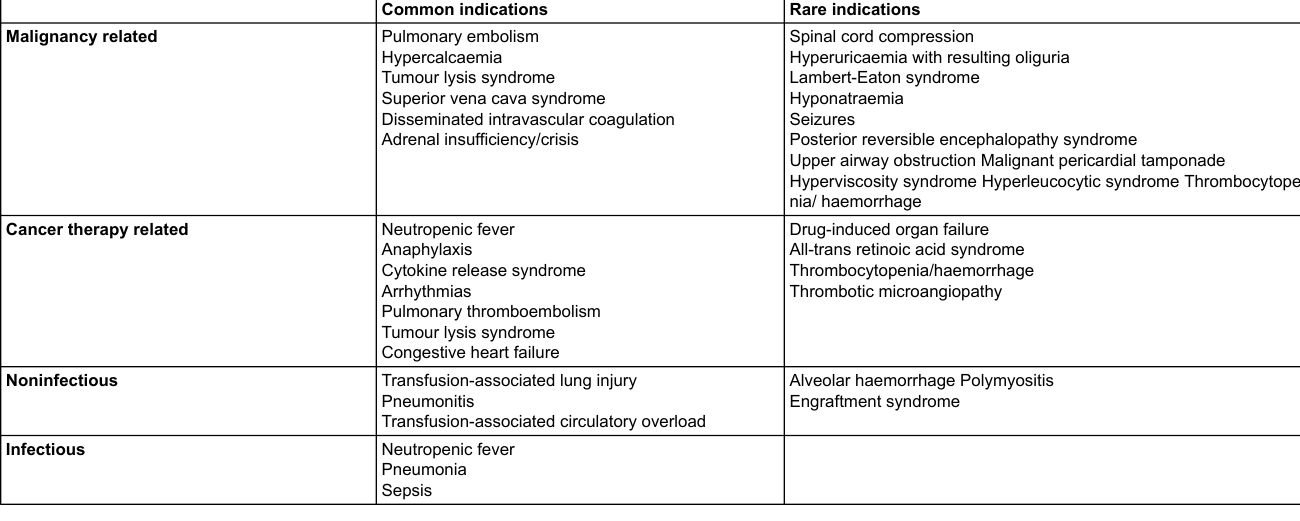
Table 1: Diagnosis at ICU admission in cancer patients. Common indications Rare